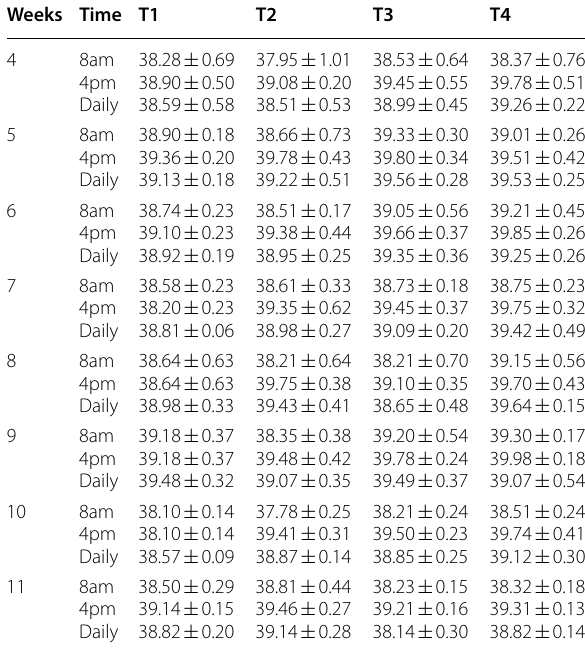
Table 5 Rectal temperature (°C) of rabbit bucks administered ascorbic acid and sodium